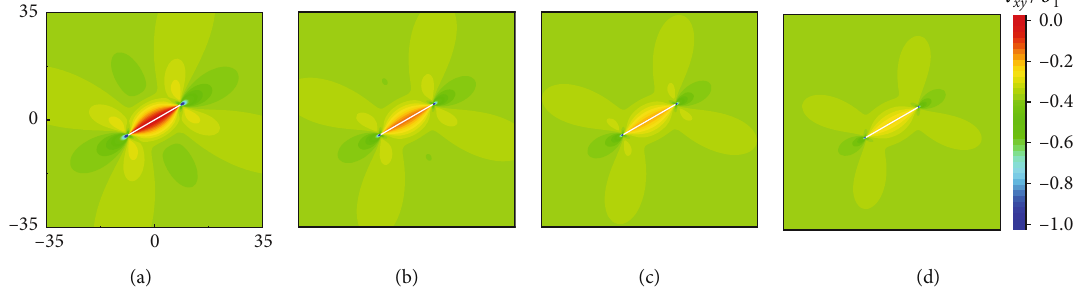
Figure 18: The contour plot of normalized τ